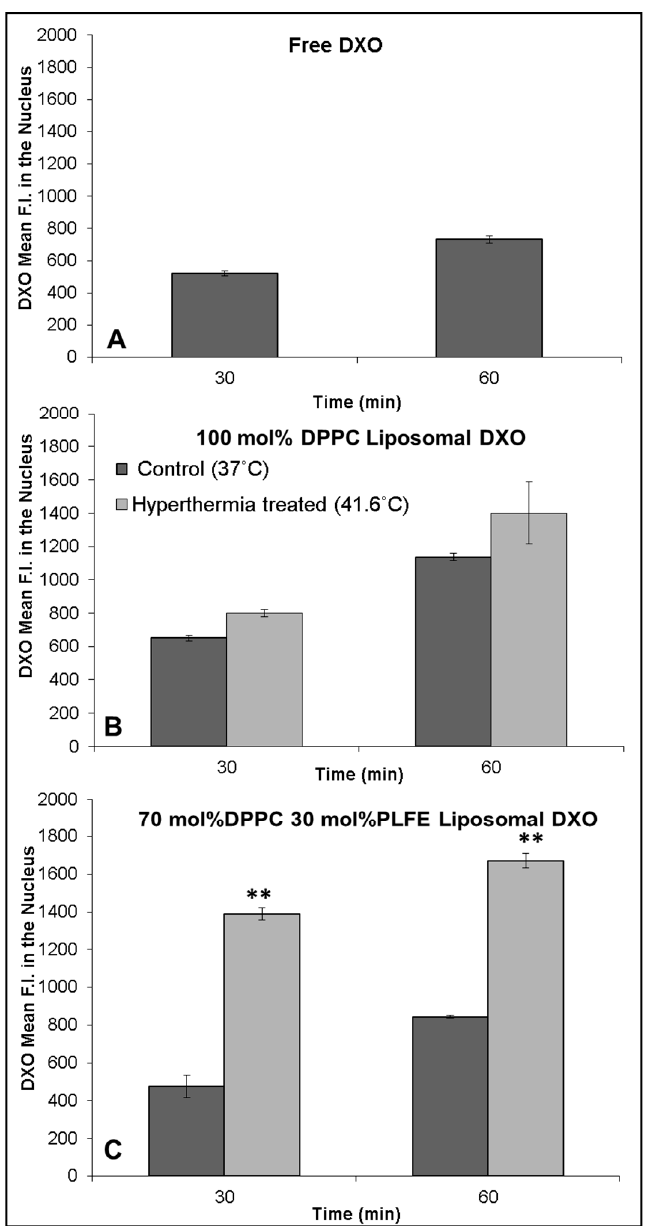
Figure 7. Effect of hyperthermia treatment on DXO’s entering into the nucleus of MCF-7 cells. Fluorescence intensity (F.I.) of DXO in the nucleus of MCF-7 cells was measured after incubation with free DXO ( A ), 100 mol % DPPC liposomal DXO ( B ) and PLFE/DPPC(3:7) archaeosomal DXO ( C ) for